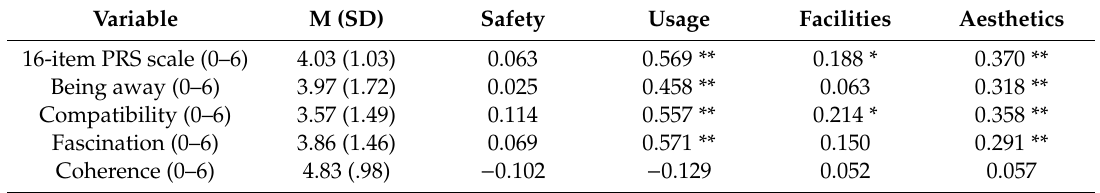
Table 2. Bivariate analysis between perceived restorativeness and environmental qualities ( N = 134). Variable Safety Usage Facilities